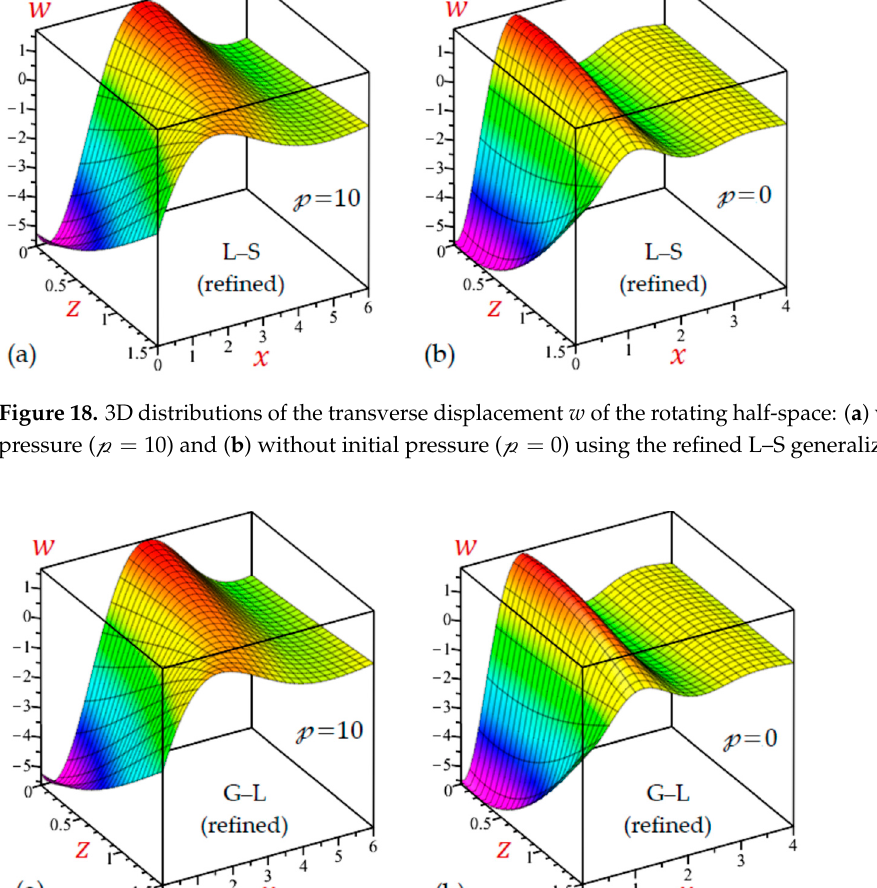
Figure 19. 3D distributions of the transverse displacement 𝑤 of the rotating half-space: ( a ) with